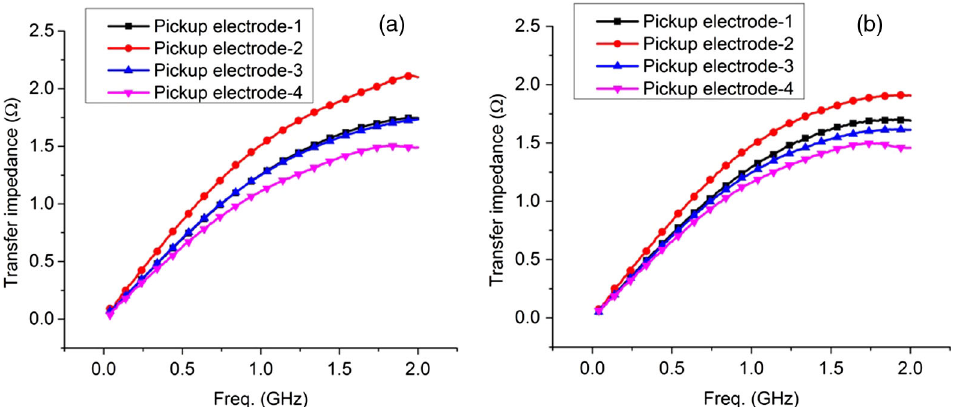
FIG. 13. Transfer impedance of different electrodes of IDBPI measured using modified coaxial wire method. (a) 1.5 mm wire diameter and (b) 0.6 mm wire